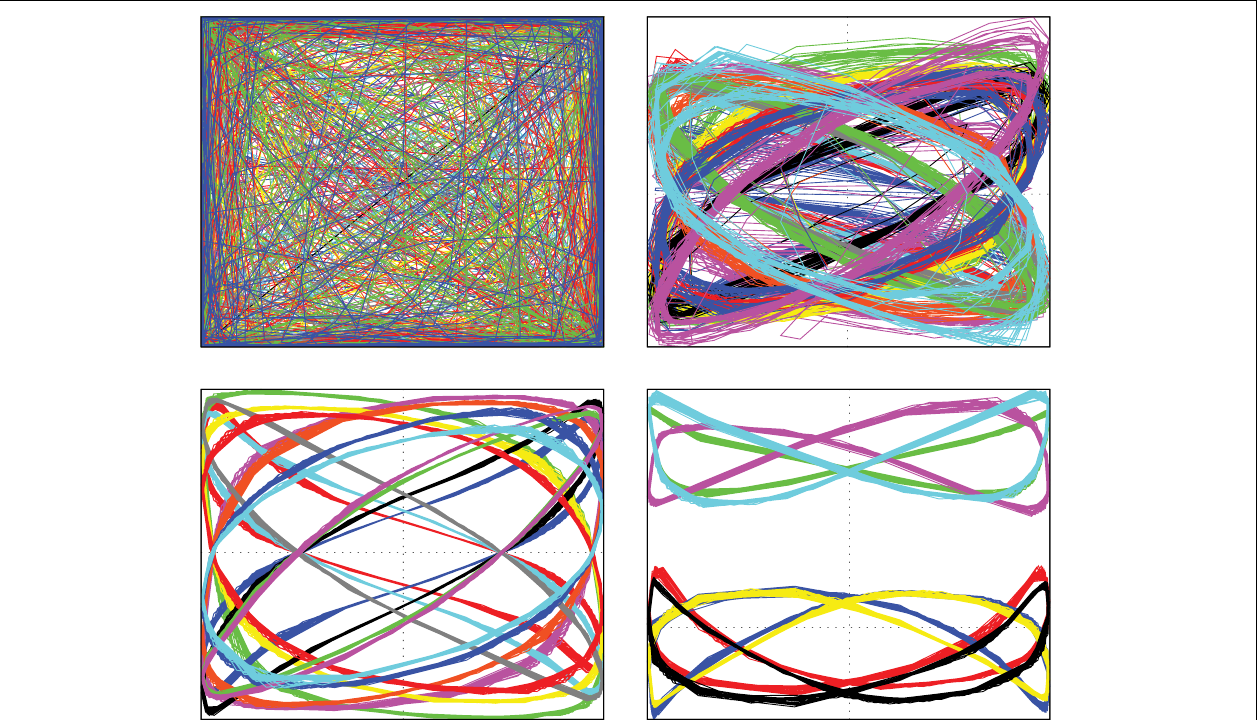
FIGURE 5 | Parametric plots demonstrating the formation of a mode and the emerging dimensionality reduction . The first three panels depict the sensor values x i ( t ) with i = 0. 13 against the controller output y 6 ( t ) in a time interval of 500 steps (10s). Top left depicts the behavior in the transition phase between two modes with fully developed chaos, top right depicts the formation of a new mode, and bottom left corresponds to the fully developed mode demonstrating the high degree of sensorimotor coordination. The time between these three phases is about 1min. The bottom right depicts the behavior of some of the matrix elements of C vs. y 6 , demonstrating the tight correlation of the synaptic dynamics with the behavior of the physical system.